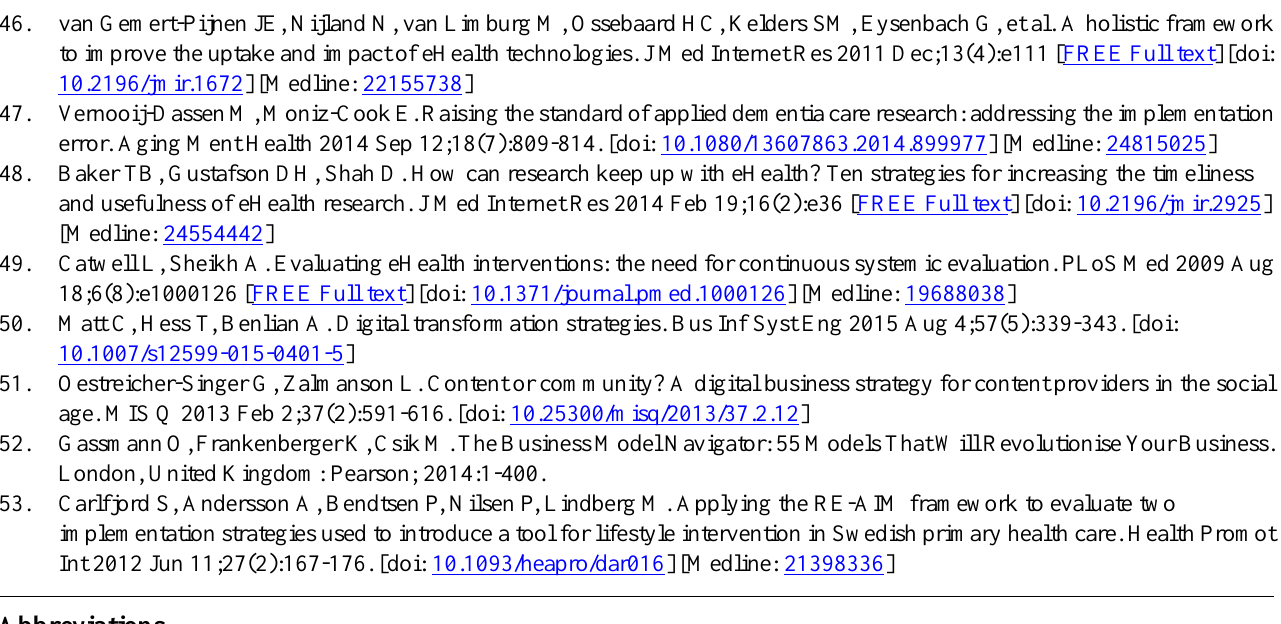
ICT: information and communication